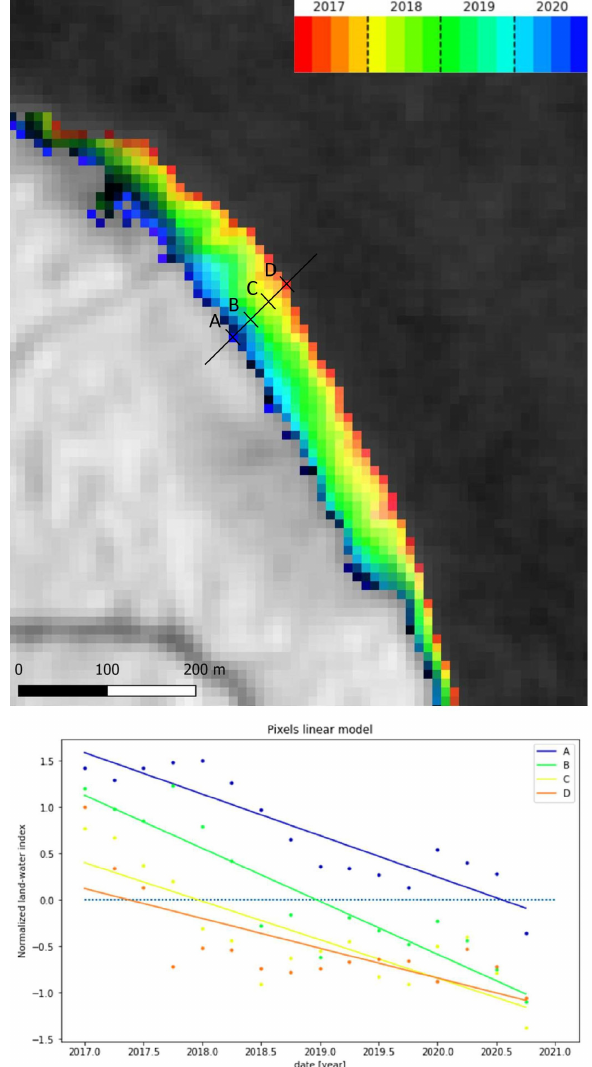
Figure 12. On the panel above: visualization of an eroded beach with the change-date used as hue. More details about the visualization can be found in Section 2.1. The background is the average r value for each pixel over the 4 years of analysis. On Figure 11. The graph depicts the cumulative distribution of the the panel below, the estimated model for the points A,B,C,D on distance between points 363 points equally spaced by 50 m on the transect visible on the upper image. The color of the data and the manually digitized coastline visible in Figure 9 and their the corresponding linear model matches the color of the pixel. closest point on the coastline detected by the proposed algorithm. panel depicts the NLWI behavior over time and confirms the previous